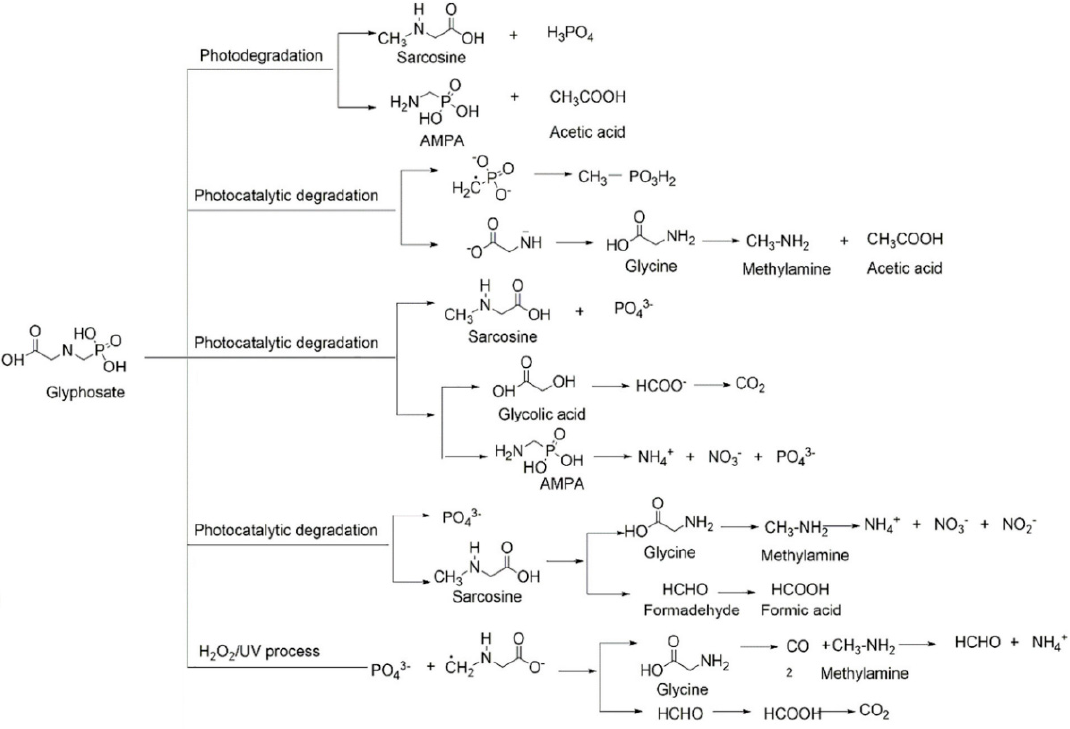
Figure 2. Glyphosate photodegradation pathways (adapted after